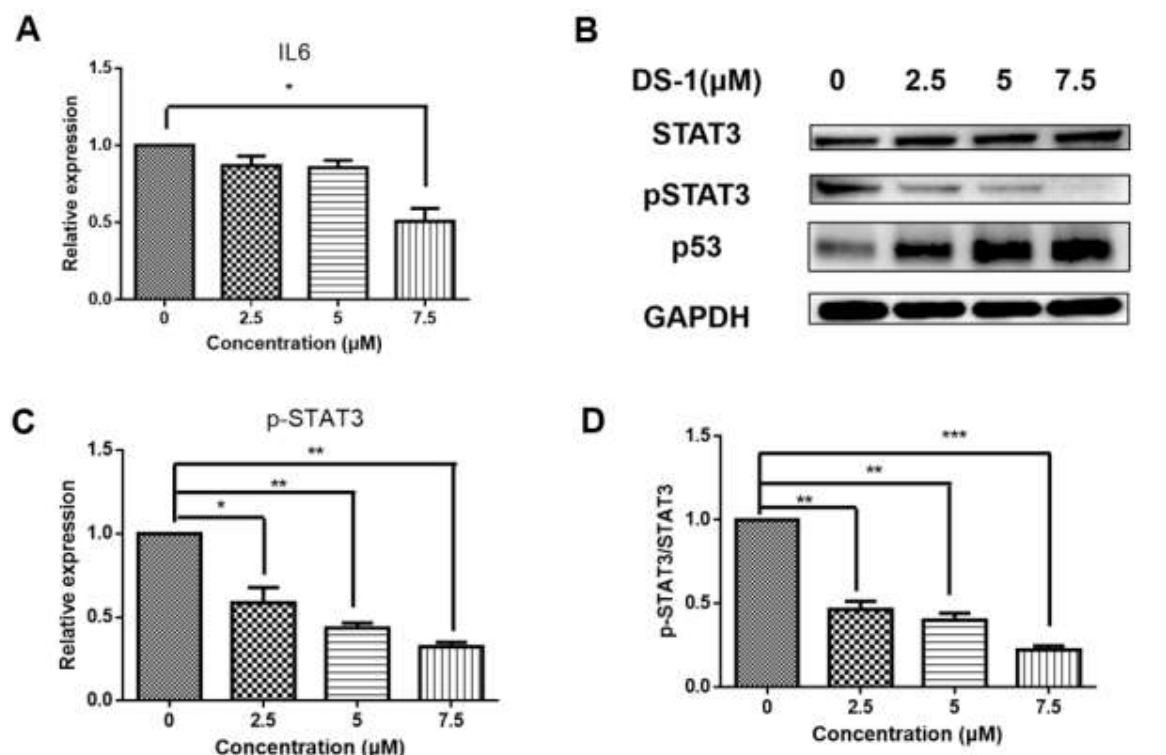
Figure 10. DS − 1 inhibited the phosphorylation of STAT3. ( A ) U − 2OS cells were treated with DS − 1 at 0, 2.5, 5.0, and 7.5 µM for 24 h, and the change in IL-6 mRNA was analyzed by RT-PCR and presented in the histogram. ( B ) U − 2 OS cells were treated with DS − 1 at 0, 2.5, 5.0, and 7.5 µM for 24 h, and STAT3, pSTAT3, and p53 were analyzed by Western blot. ( C ) The expression of pSTAT3 is shown in the histogram. ( D ) The pSTAT3/STAT3 value is shown in the histogram. Values are the average of three independent experiments, * p < 0.05, ** p < 0.01, *** p < 0.005.